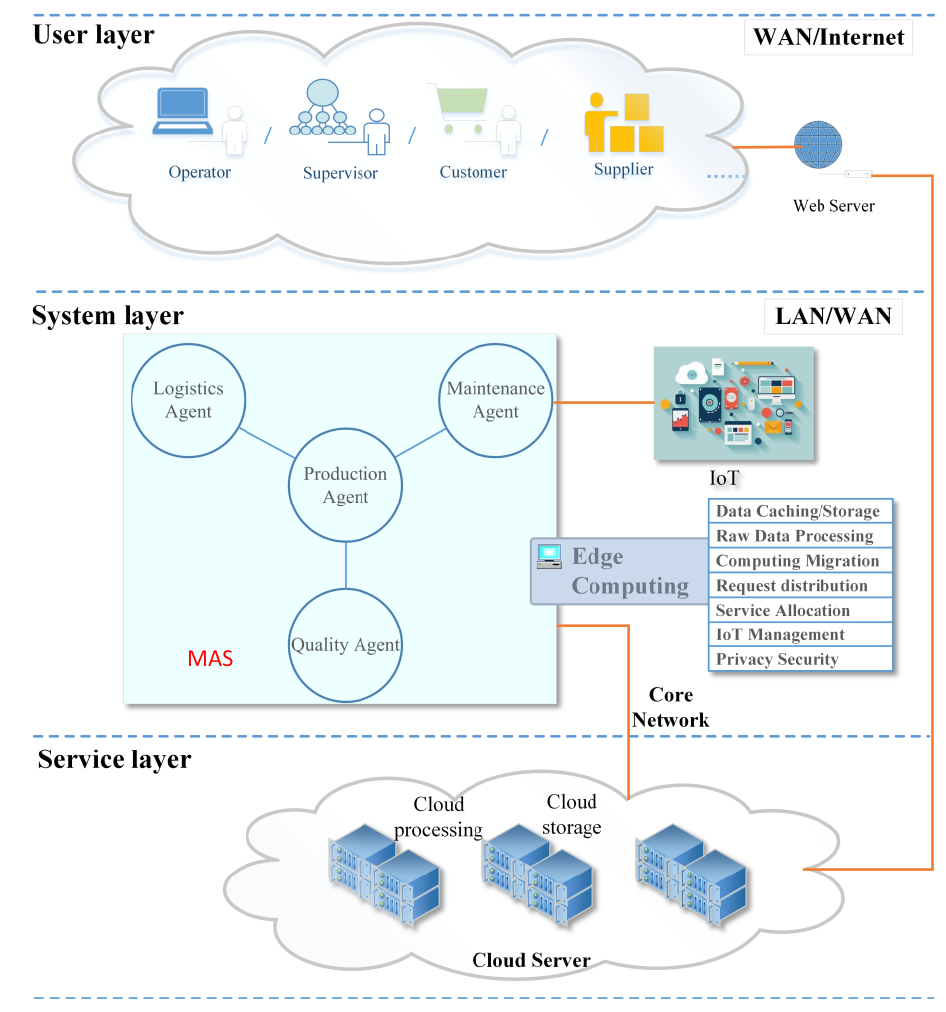
Figure 1. Overview of the virtual manufacturing environment (VME) architecture.